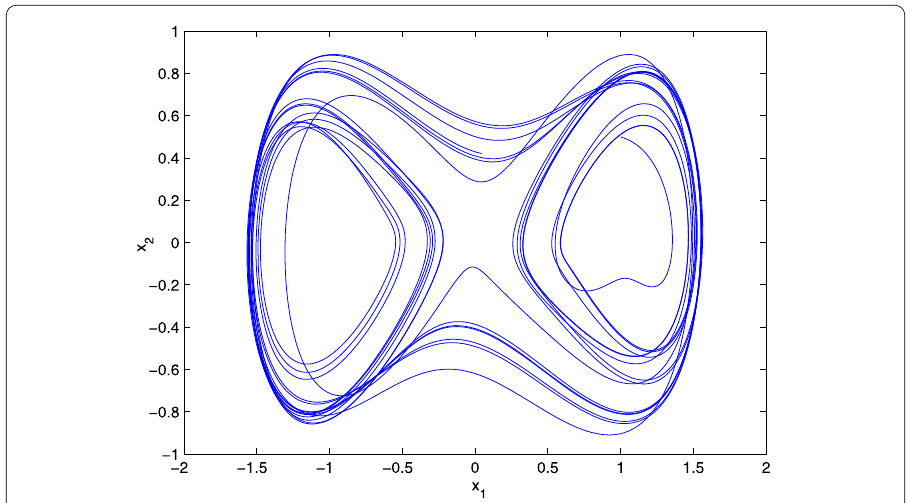
Figure 1 Chaotic attractor of system (4.1) with μ = 0.5, ω = 1, γ = 0.2, and α =